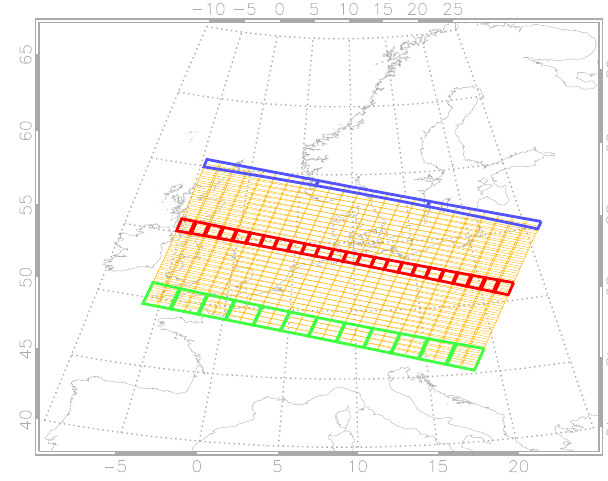
Fig. 5a. Averaging kernels for the 40-layer GOME retrieval over Europe that was also used in Fig. 1. The circles give the nominal altitude for the retrieval. The averaging kernels corresponding to the albedo and the additive offset have not been plotted.